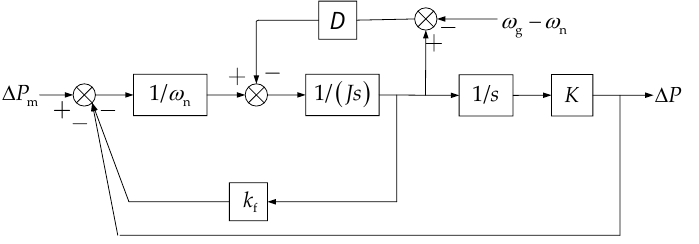
Figure 10. VSG small signal analysis model.